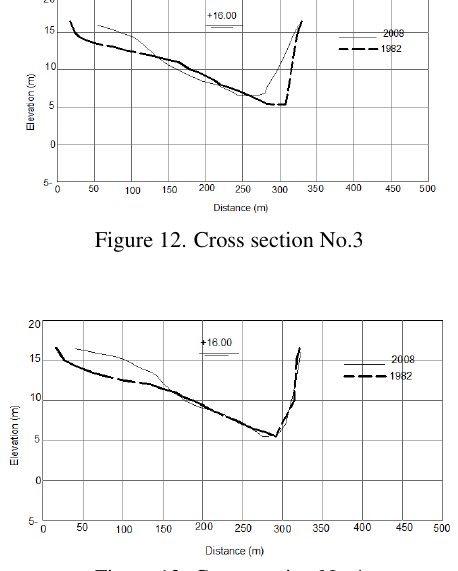
Figure 13. Cross section No.4